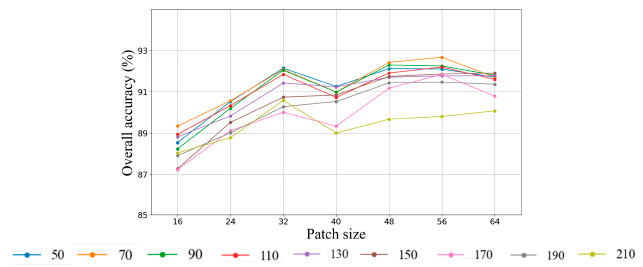
Figure 16. The variation of overall accuracies over patch sizes (different curves represent different segmentation scales).